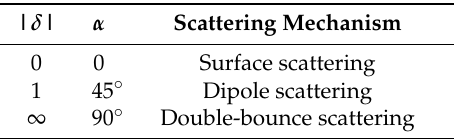
Table 3. The general relationship between | δ | and α